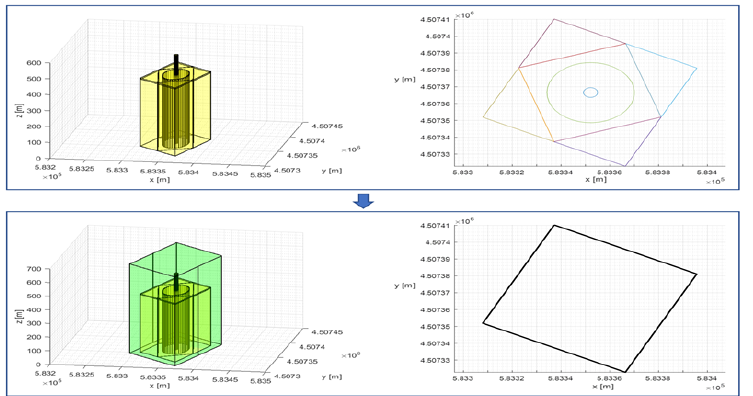
Figure 9. Post-processed georeferenced data for the One World Trade Center building in Manhattan. The top left and right show raw OSM data side and top views, respectively. The bottom left and right show post-processed keep-out geofence data (shaded in green) side and top views,